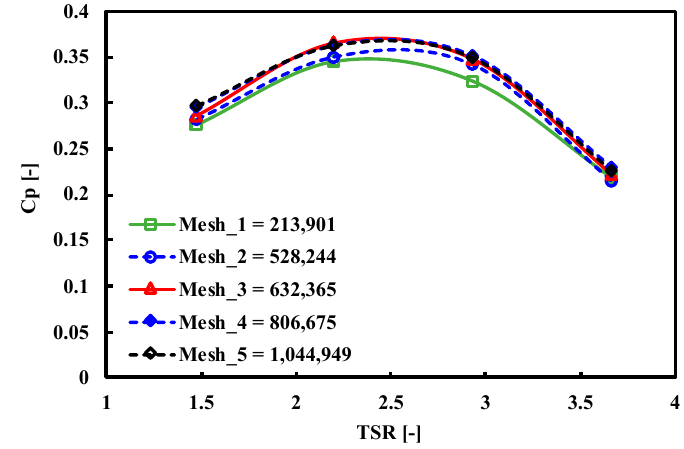
Figure 8. Grid sensitivity study (Power coefficient with mesh size at various TSR ).